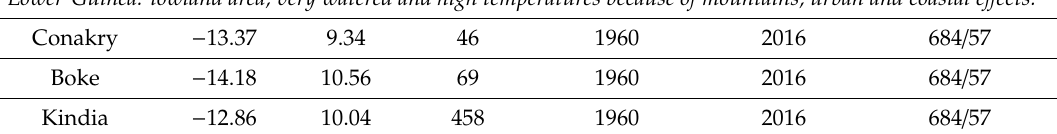
Kindia Middle-Guinea: mountainous area, both lower temperature (Labe and Mamou) and higher temperature (Koundara). Labe Mamou Koundara Upper-Guinea: Upland area, high temperatures and lower rainfall. Kankan